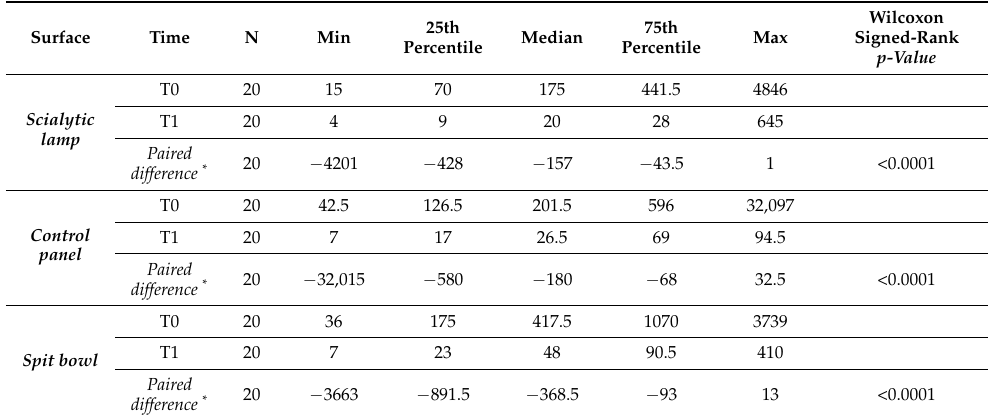
Table 3. Distributions of the RLU values for each evaluated surface; ( p < 0.05). A cut-off of 150 RLU was set to consider a surface clean.